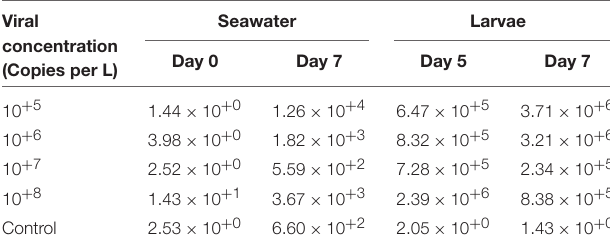
TABLE 4 | Quantification of OsHV-1 DNA in seawater (copies per µ L) at days 0 and 5 post-exposure, and in larvae (copies per ng of DNA) at days 5 and 7 in trial